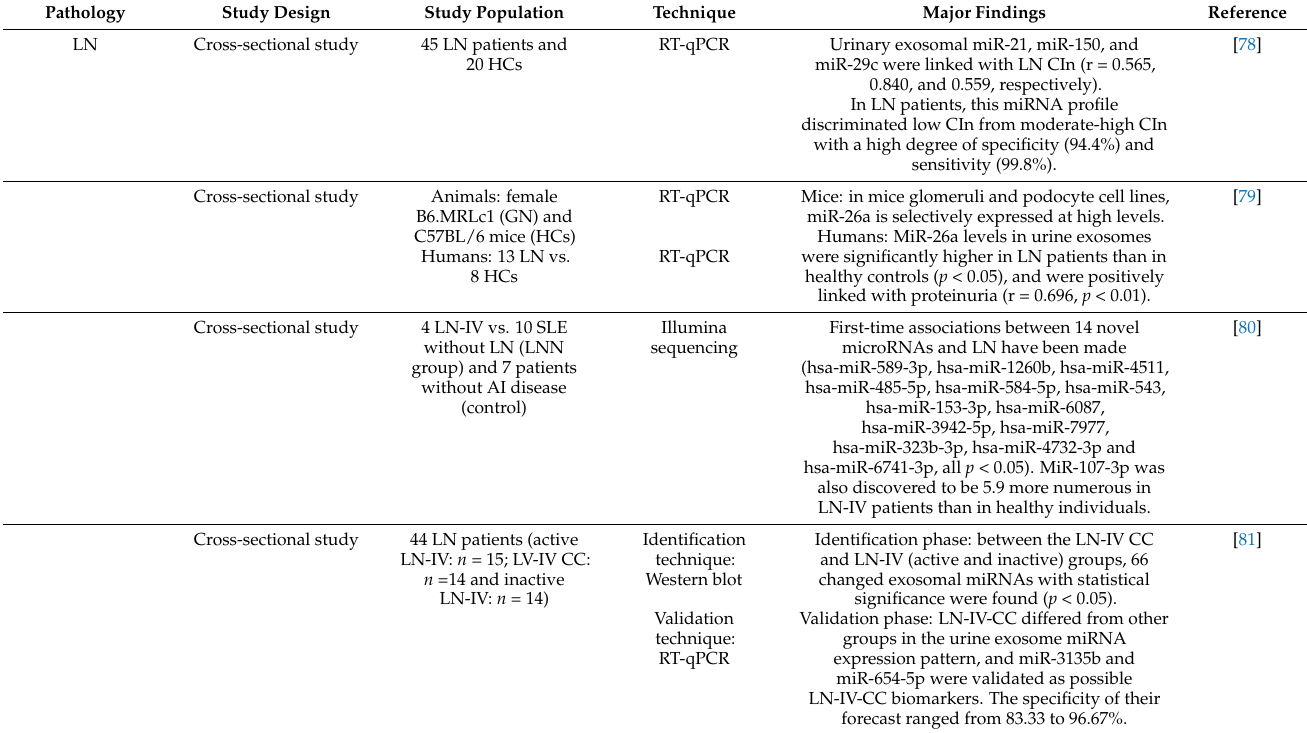
Table 3. Overview of studies of urinary extracellular vesicles in lupus nephritis and